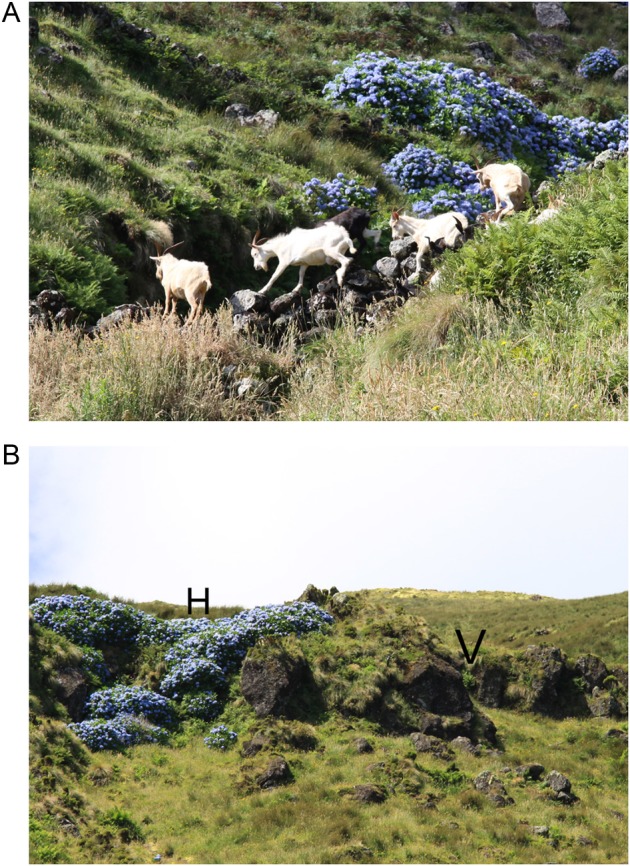
Two of the most relevant threats affecting V. dabneyi populations in the Azores: (A) feral goats free roaming and grazing very close to Madeira Seca in Corvo Island; (B) Hydrangea macrophylla clumps very close to a rock outcrop in Madeira Seca.